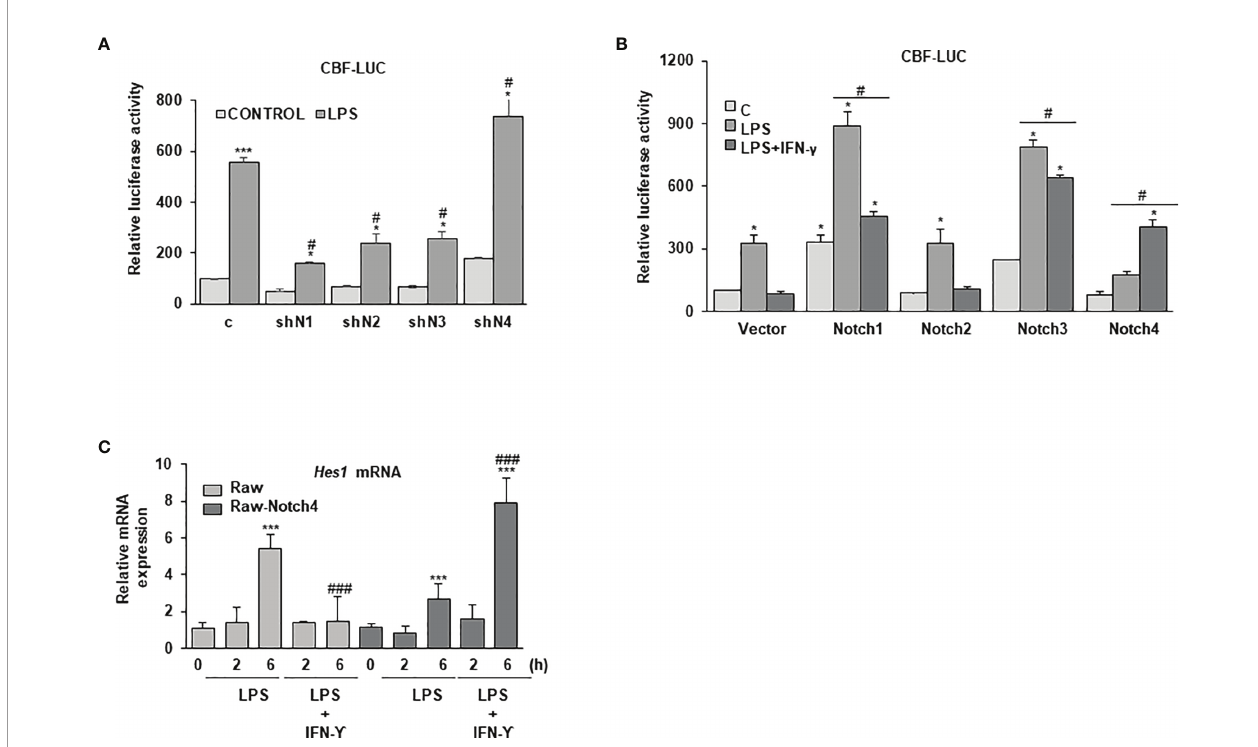
FIGURE 5 | Effect of NOTCH4 on NOTCH transcriptional activity in macrophages activated with LPS and IFN- g . (A) NOTCH transcriptional activity analysis in Raw264.7 cells transiently transfected with a CBF-1 luciferase reporter gene (CBF-luc) and speci fi c shRNAs for the different Notch receptor genes or control shRNAs or (B) expression vectors for the different Notch receptors or their corresponding empty vectors. One day after transfection, cells were stimulated with LPS (100 ng/ ml) (A) and/or LPS and IFN- g (10 U/ml) (B) for 24 h before analysis. The means ± SD of three independent experiments are shown. One-way ANOVA/Bonferroni ’ s post-tests were performed. *p<0.05 compared to the control transfected cells. # p<0.05 compared to the corresponding LPS or LPS and IFN- g treated control transfected cells. (C) Quantitative PCR analysis of Hes1 expression in Raw 264.7 cells transfected with a Notch4 expression vector (Raw-Notch4) or its corresponding empty vector (Raw) for 24 hours; cells were then stimulated for different times with LPS or LPS and IFN- g . RNA expression was referred to that of the P0 housekeeping gene used as a control. Quantitation of three different experiments is shown. One-way ANOVA/Bonferroni ’ s post-tests were performed. ***p<0.001 compared to the corresponding control untreated cells. ### p<0.001 compared to the corresponding LPS treated